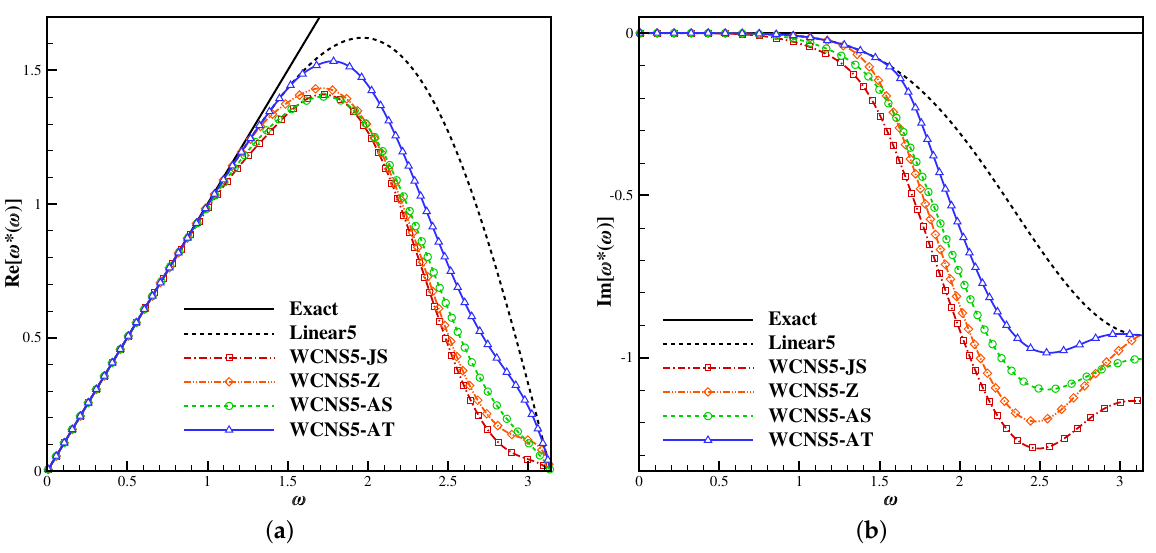
Figure 5. Approximate dispersion and dissipation properties of different fifth-order WCNS schemes: